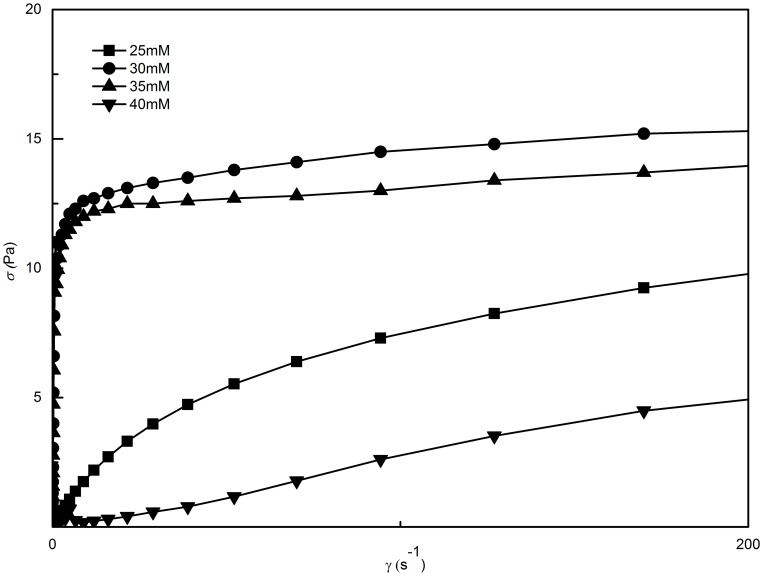
Shear stress with different concentration of SL at a fixed C16MPBr concentration of 70 Mm.